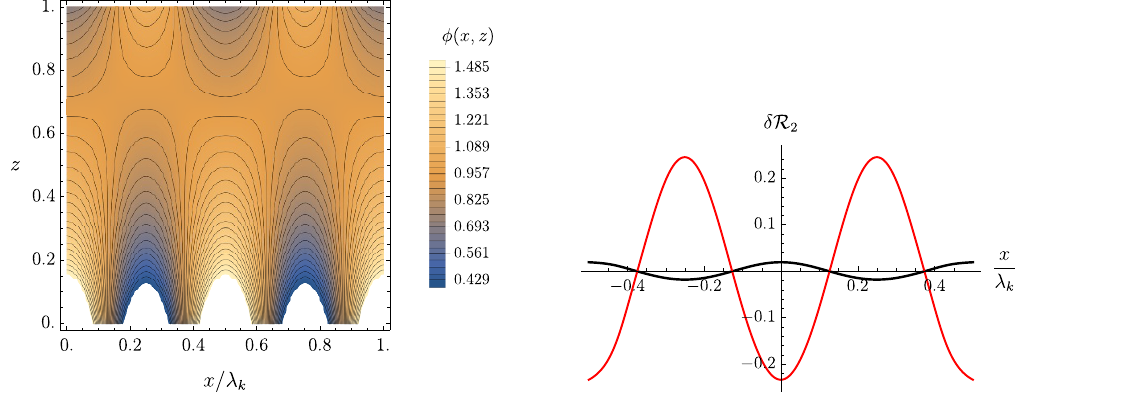
Figure 8 . Nonlinear solution in the com- mensurate phase for A = 1 ; k = 1 : 5 and low temperature T = 0 : 01. The pro(cid:12)le of (cid:30) ( x; z ) = A t ( x; z ) = (cid:22) (cid:22)f ( z ) is shown.